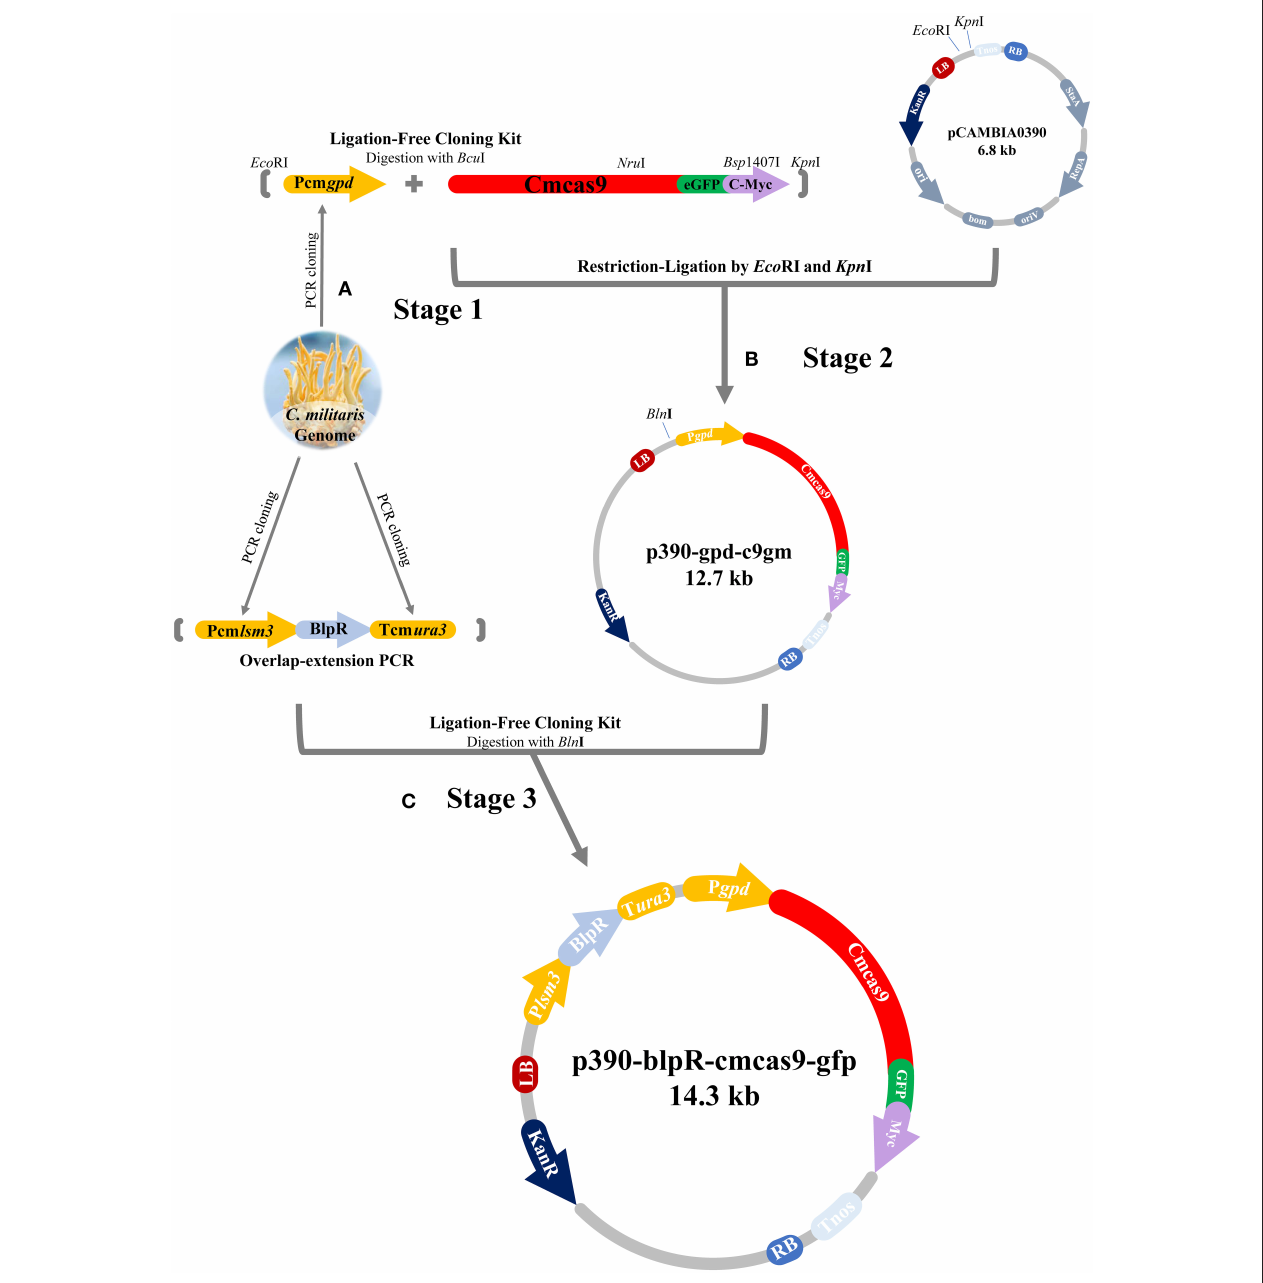
FIGURE 1 | Flow diagram of CRISPR-Cas9 vector construction. (A) Pcm gpd , Pcm lsm3 and Tcm ura3 were cloned from the genome of C. militaris . (B) The cassette P cmgpd - cmcas9 - gfp - myc was ligated into pCAMBIA0390 to build the p390cm-gpd-c9gm vector. (C) The cassette P cmlsm3 - blpR -T cmura3 was ligated